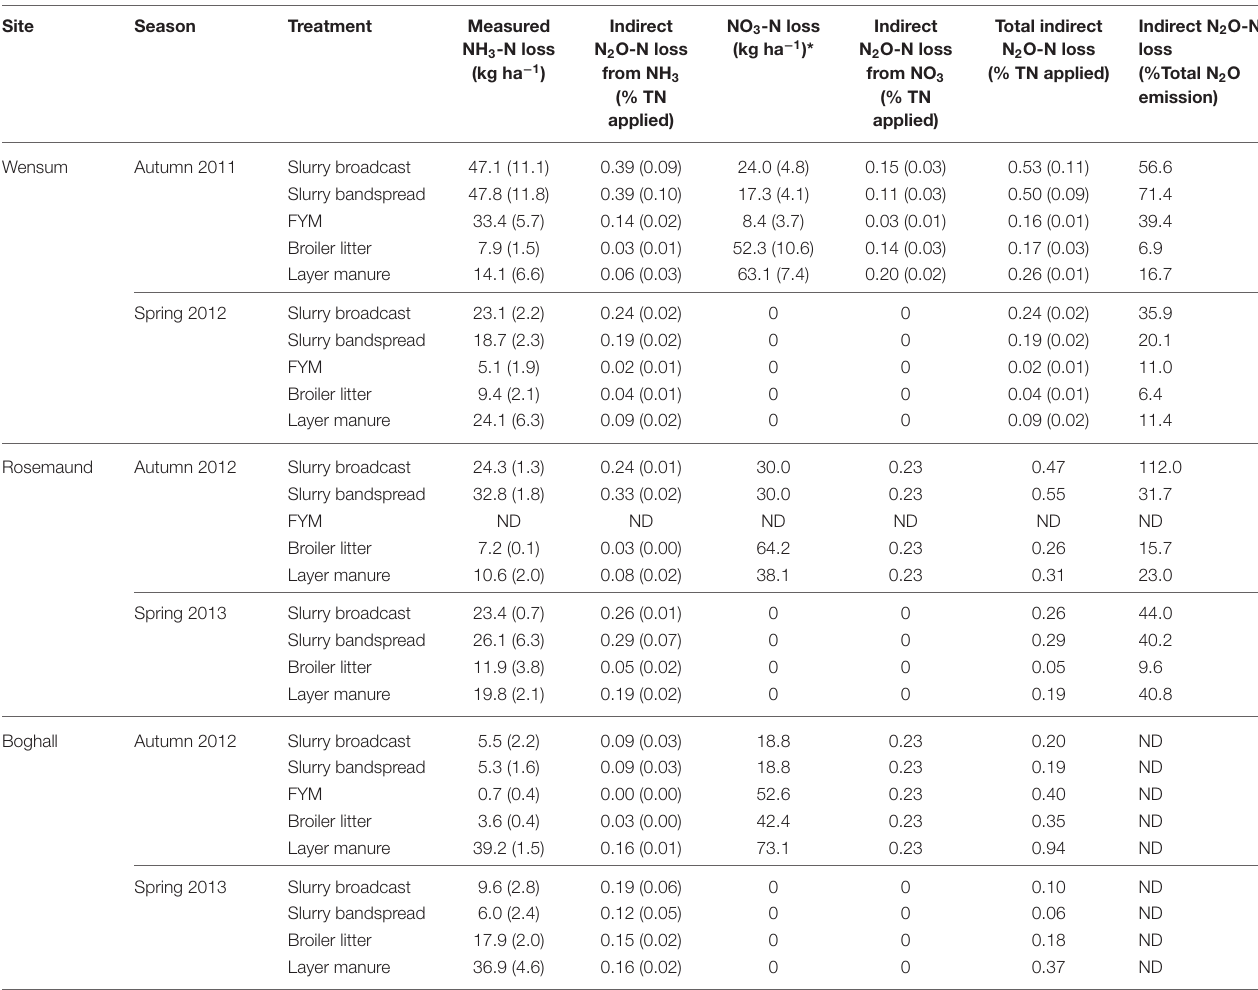
TABLE 5 | Mean NH 3 volatilization and NO 3 leaching losses and calculated indirect N 2 O emissions at the arable